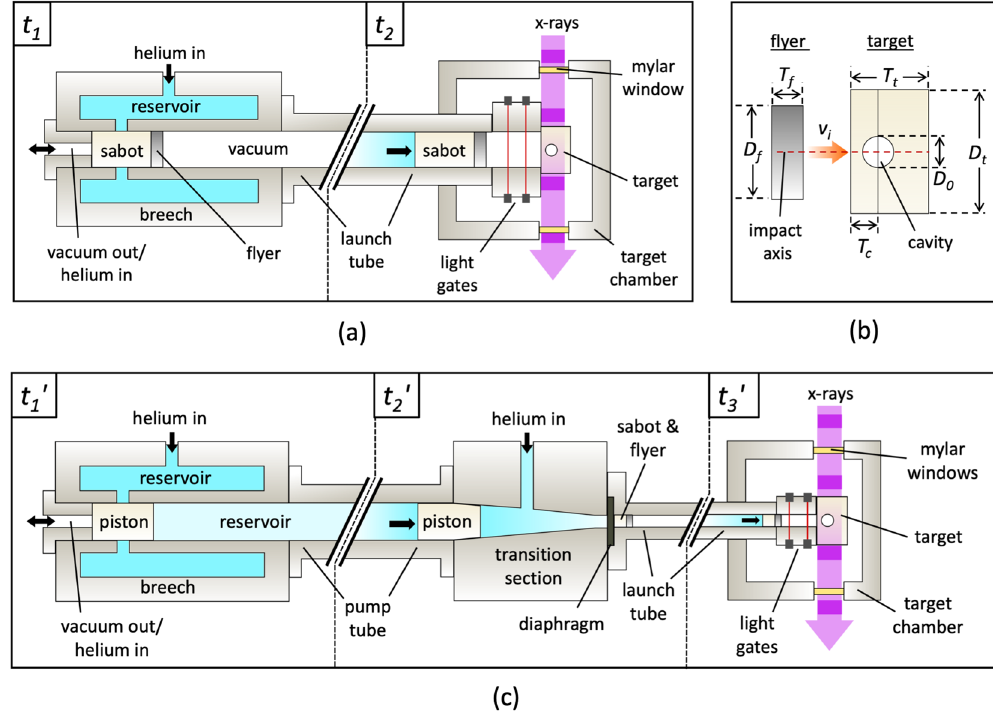
Figure 1. Schematic diagrams showing the setup for the experiments. In ( a ), for the single-stage experiments, the projectile is accelerated toward the target under the action of a single high-pressure reservoir. ( b ) An enlarged view of the flyer plate and target, which have cylindrical symmetry about the axis of impact. ( c ) For the two-stage experiments, high-pressure gas accelerates a piston towards a transition section, compressing and heating the helium gas ahead of it. This gas subsequently bursts a diaphragm, launching a sabot toward the target mounted at the end of the muzzle. Both gun systems are oriented normal to the X-ray beam to capture the transverse profile of the shock wave and